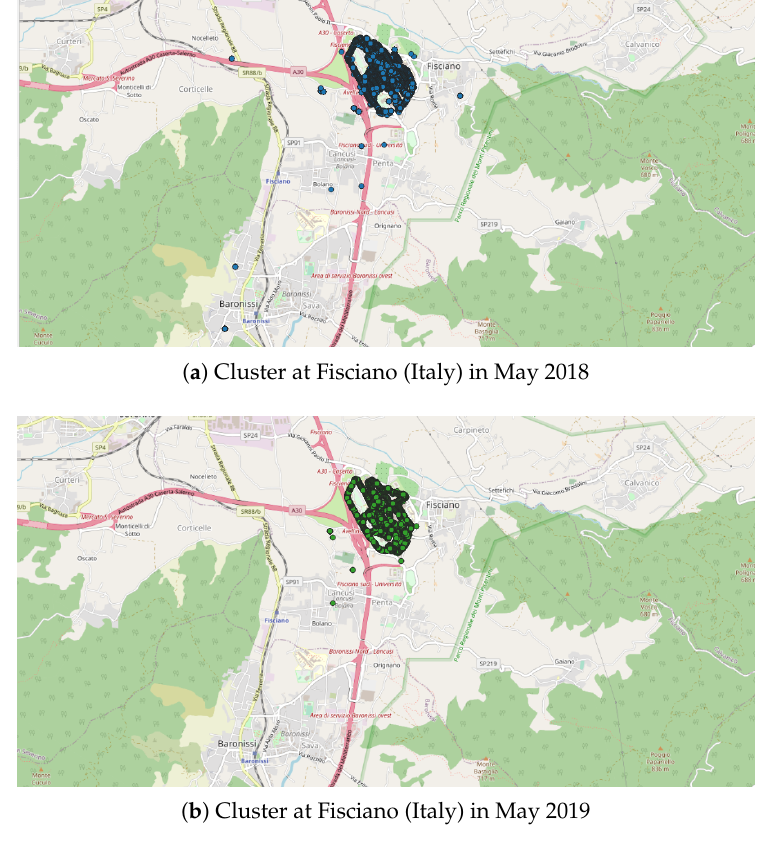
Figure 9. Representation of the 2 clusters found in Italy, at Fisciano. Both clusters correspond to NC party events: ( a ) NC party Id N°10 in May 2018; ( b ) NC party Id N°26 in May 2019; represented area of approximately 4.5 km × 8.9